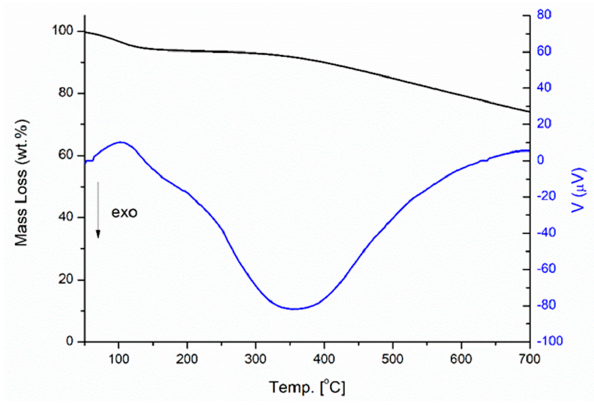
Figure 6. TG (black)-DTA (blue)- curve of CGB under static air.